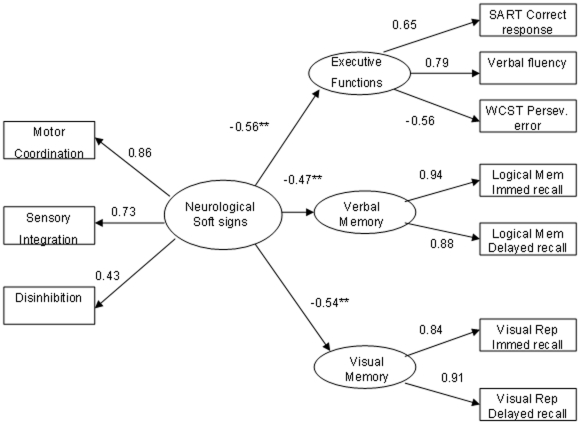
The structure model of the influence of Soft Sign on cognitive function in patients with schizophrenia.χ2 (29) = 39.48, p = 0.093, NFI = 0.96, NNFI = 0.98, CFI = 0.99, IFI = .99, RMSEA = 0.056. Note. * p<0.05, ** p<0.01.